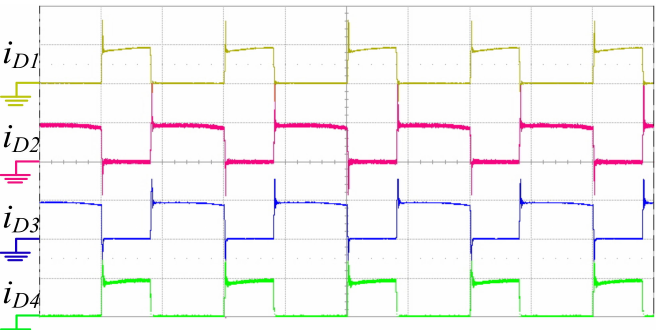
Figure 7. Current waveforms of rectifying diodes. ( i D1 , i D2 , i D3 , i D4 : 1 A / div, Time: 10 µ s /